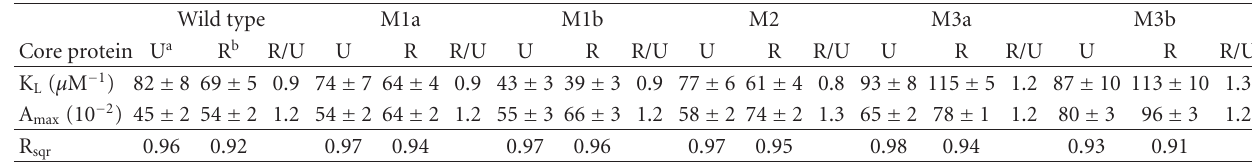
Table 1: K L (a ffi nity) and A max (maximum binding capacity) of HCV core